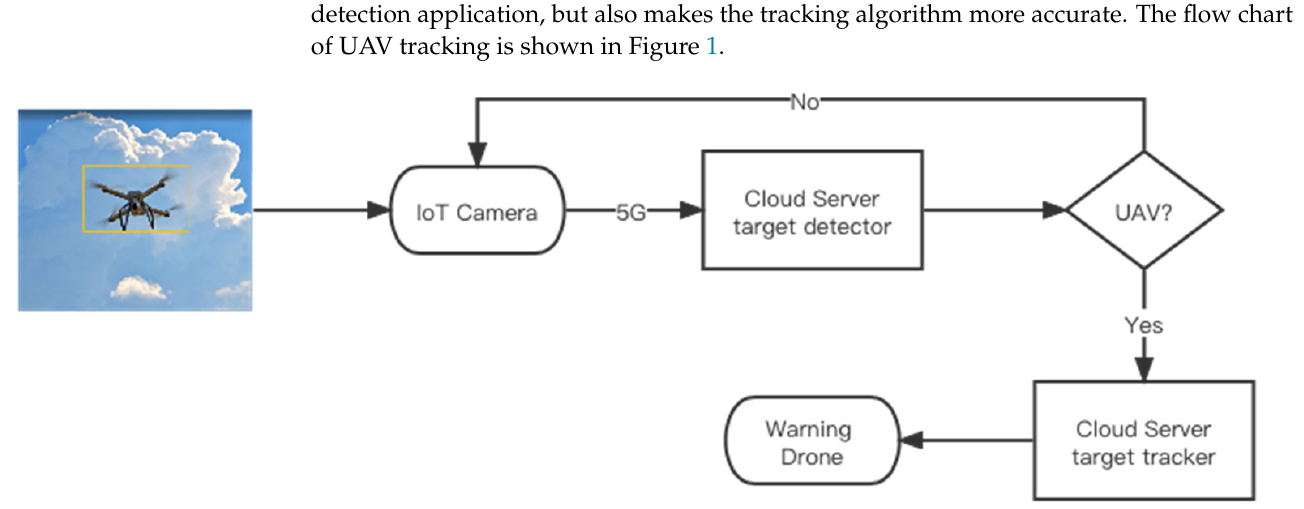
Table 1. Object detection algorithm